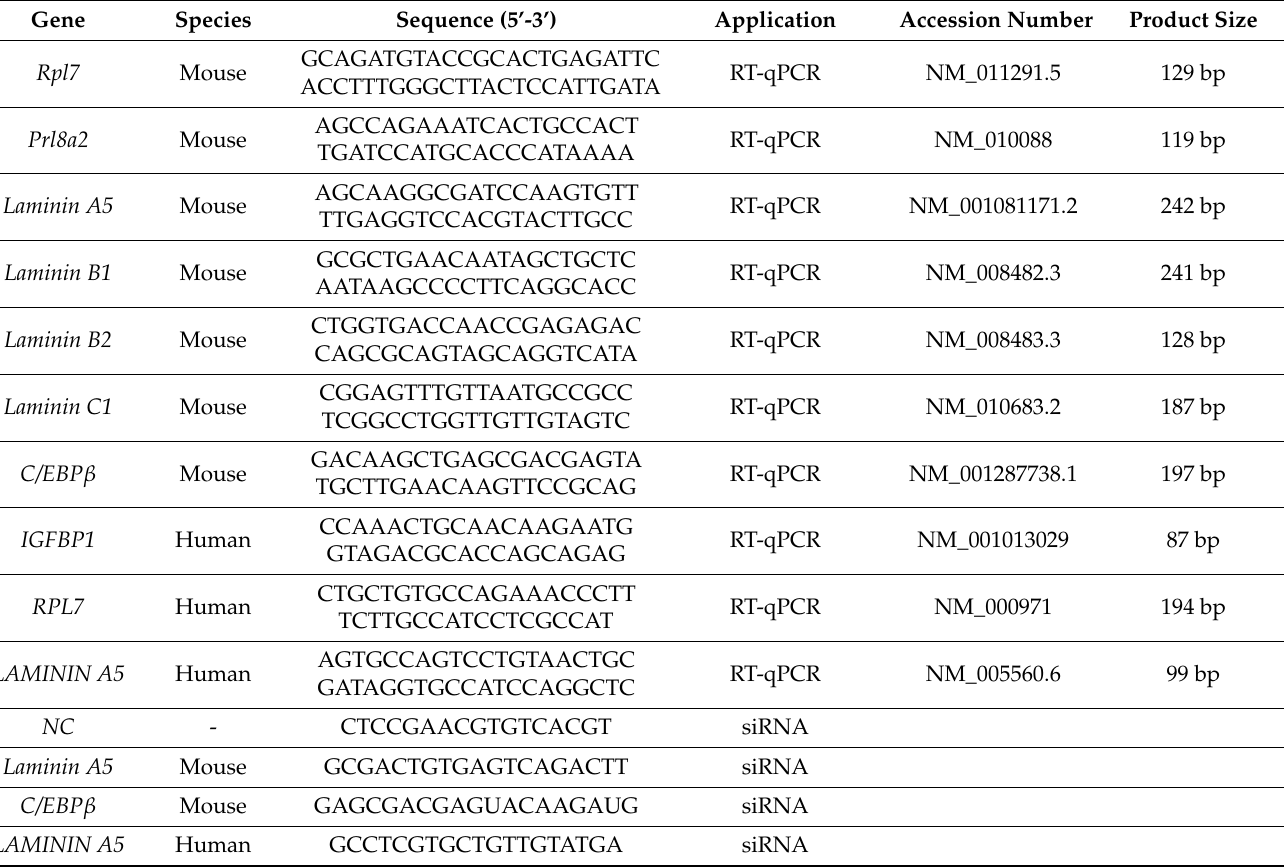
Table 1. Primers and siRNA sequences used in this